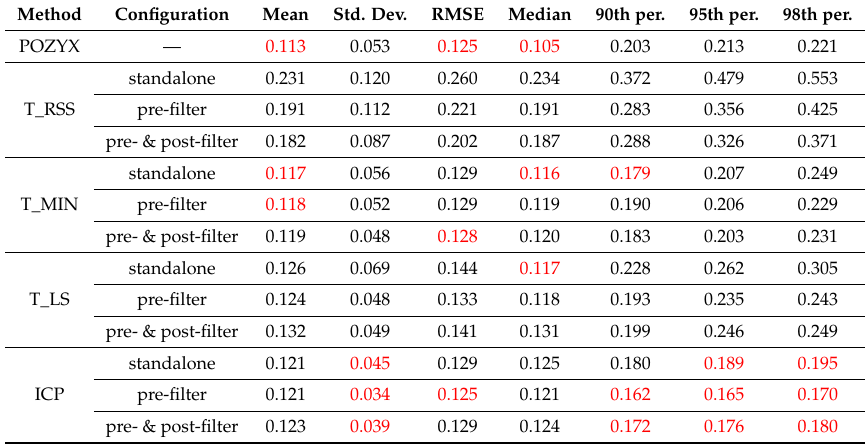
Table 2. Performance data for the rectangular trajectory. Values in red denote the three best values for each metric. All values are in meters.